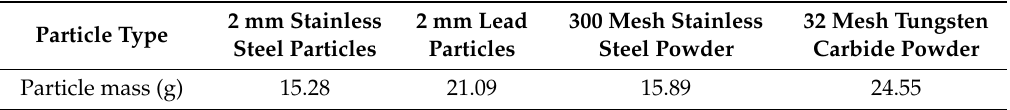
Table 3. Particle mass ( V r = 1, C2 Cavity).